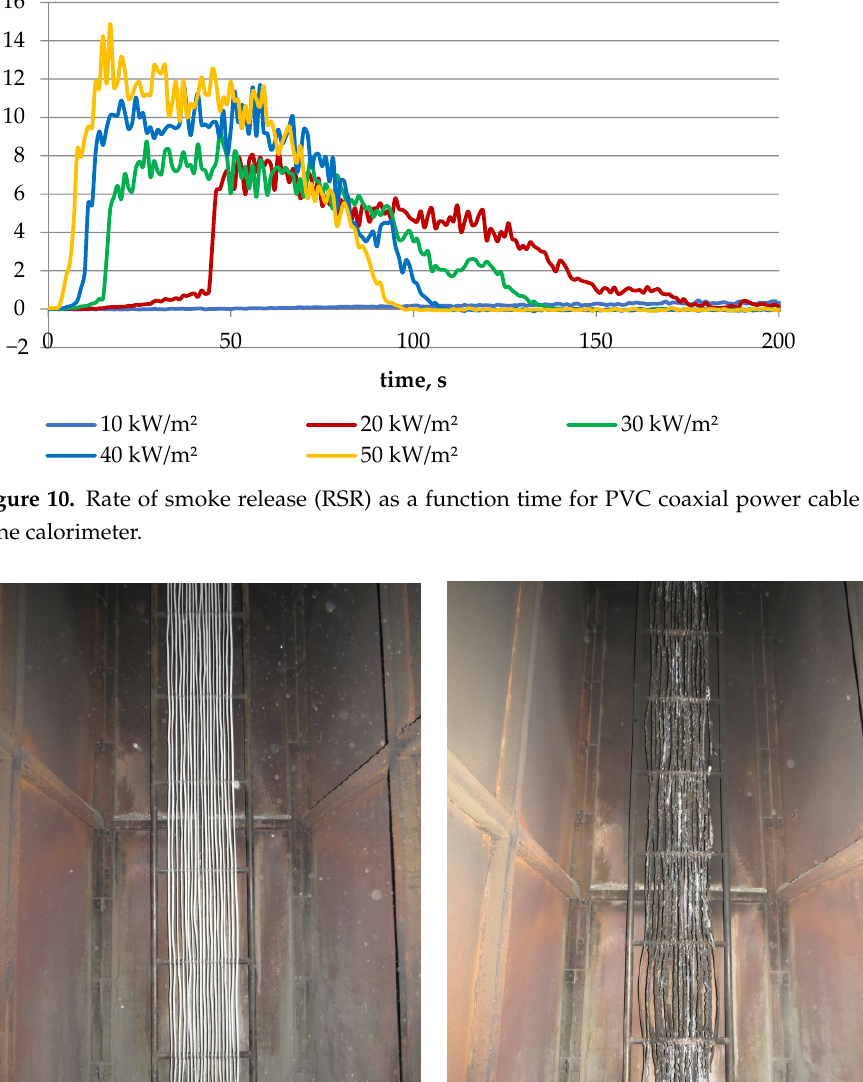
Figure 10. Rate of smoke release (RSR) as a function time for PVC coaxial power cable tested in cone calorimeter.